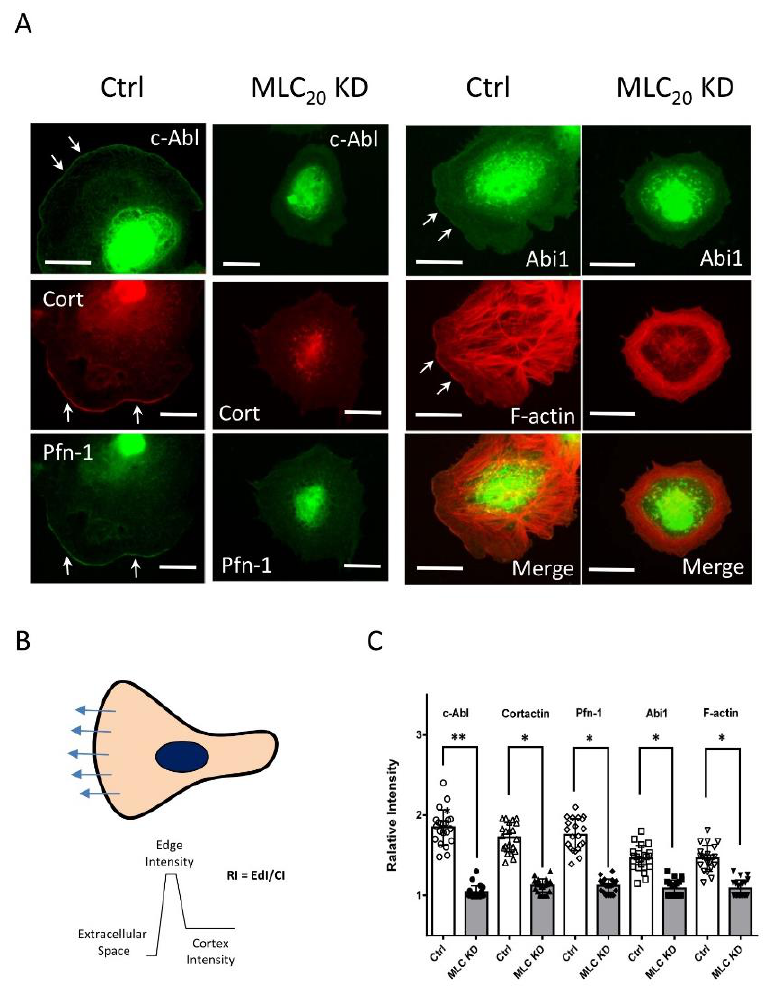
Figure 3. MLC 20 regulates the recruitment of c-Ab, cortactin, Pfn-1, and Abi1 to the cell edge. ( A ) Ctrl and MLC 20 KD cells were plated onto collagen-coated coverslips for 30 min followed by immunofluorescence and fluorescence analysis. MLC 20 KD attenuates the localization of c-Abl, cortactin (cort), Pfn-1, Abi1, and F-actin at the cell edge. The arrows point to the leading edge. Scale bar: 10 µ m. ( B ) Illustration of quantitative analysis. An average of at least 5 line scans across each cell is used for analysis. Relative Intensity (RI) = Edge Intensity (EdI)/Cortex Intensity (CI). ( C ) Data are mean values of experiments from at least 20 cells for each group. Error bars indicate SD. One-way ANOVA was used for statistical analysis. ** p < 0.01; * p < 0.05.